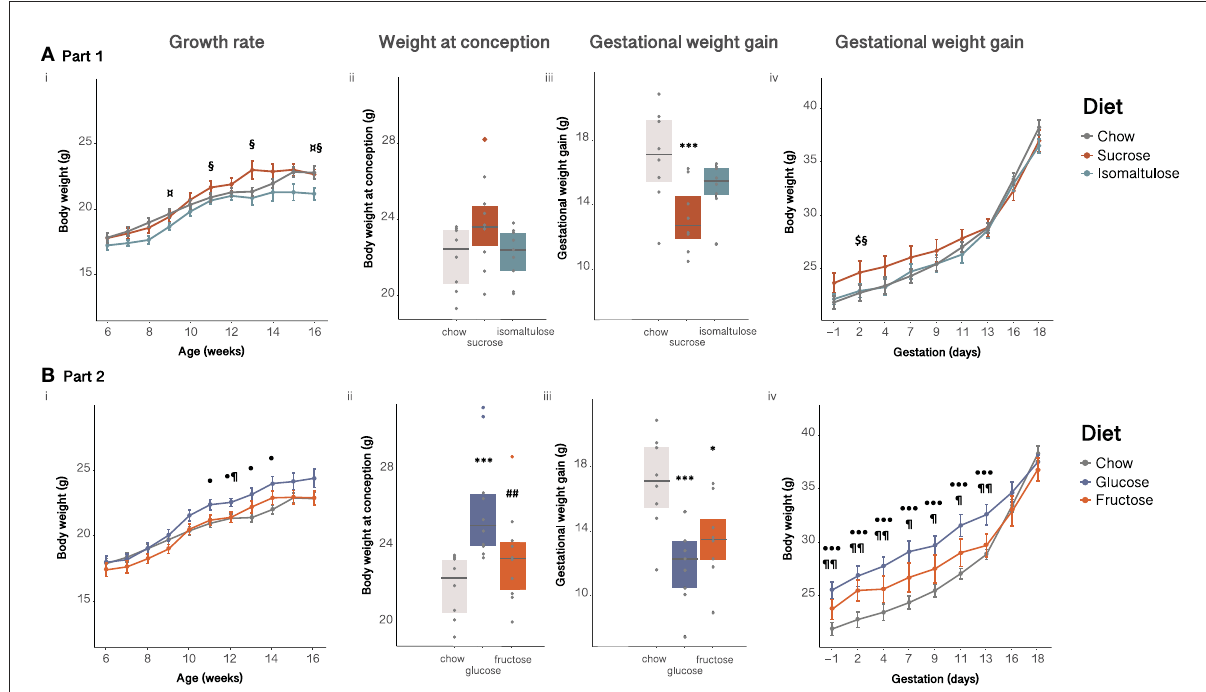
FIGURE1 Dam body weight (A) in Part 1 and (B) in Part 2: (i) pre-pregnancy, (ii) at conception, (iii) gained during pregnancy, (iv) during pregnancy. n = 8–10 per diet. Line graphs depict data as mean ± SEM. * p < 0.05 vs. chow; *** p < 0.001 vs. chow; ## p < 0.01 vs. glucose; $ p < 0.05 sucrose